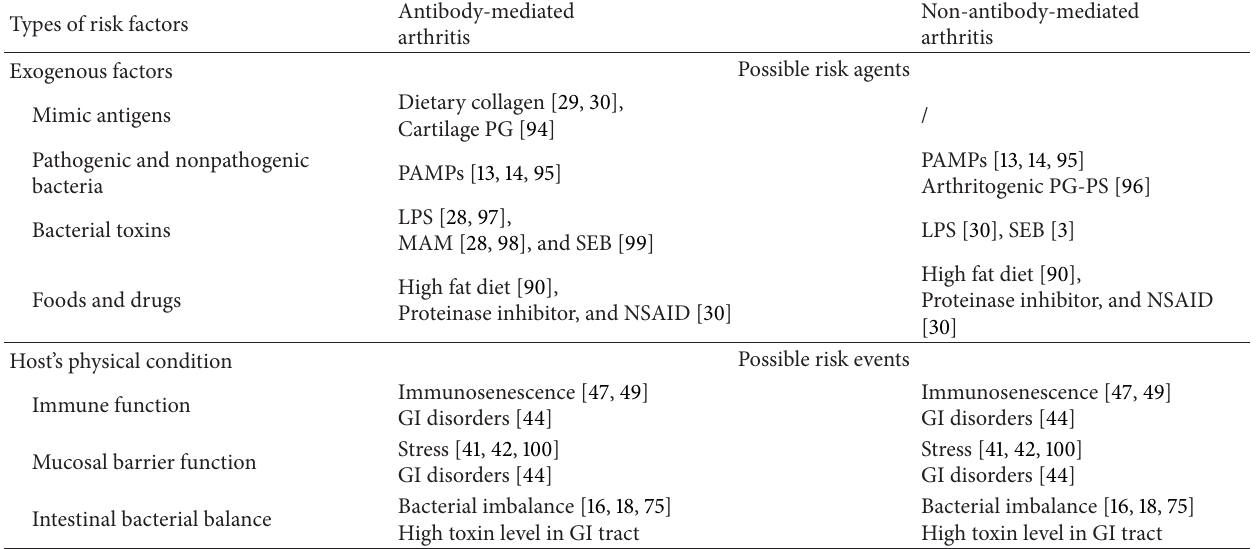
Table 1: Internal and exogenous factors possibly involved in the pathogenesis of RA and other ADs: two unrelated types of risk factors apparently contribute to the development of ADs: the first is environmental exogenous factors, and the second is the host’s physical condition. In addition, ADs such as RA might be classified into two types, autoantibody-mediated and non-antibody-mediated. Regardless of whether the disease is mediated by autoantibodies or not, bacterial toxins absorbed from the intestine directly trigger and exacerbate an inflammatory